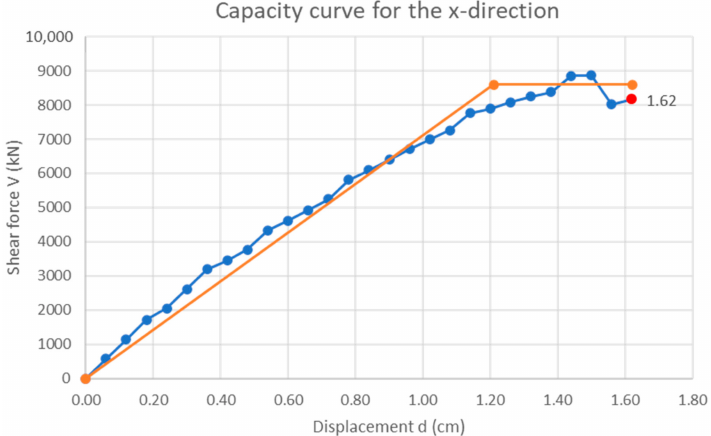
Figure 17. The most relevant capacity curve for x-direction.